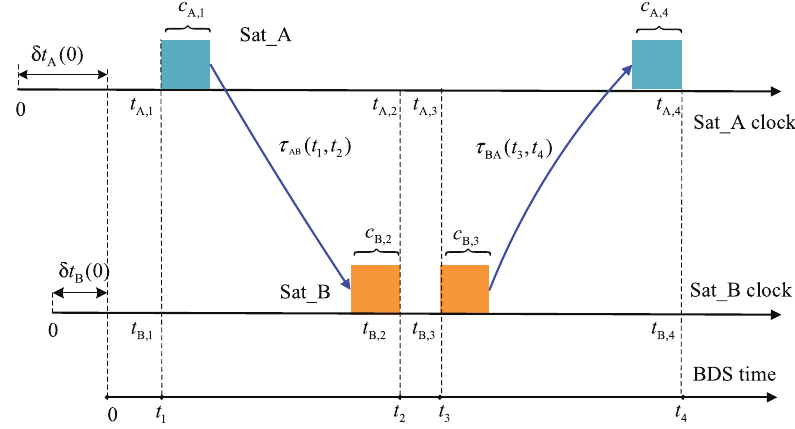
Figure 2: The dual one - way measurement process of the